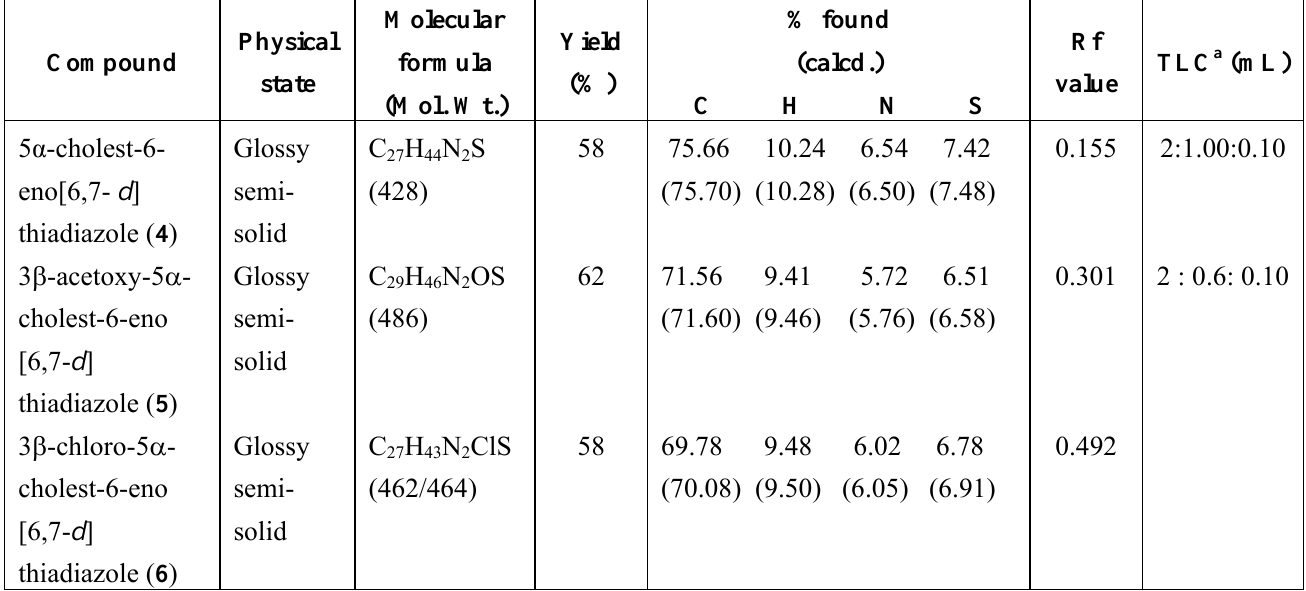
Table II. Physical properties and analytical data of compounds 4 - 6